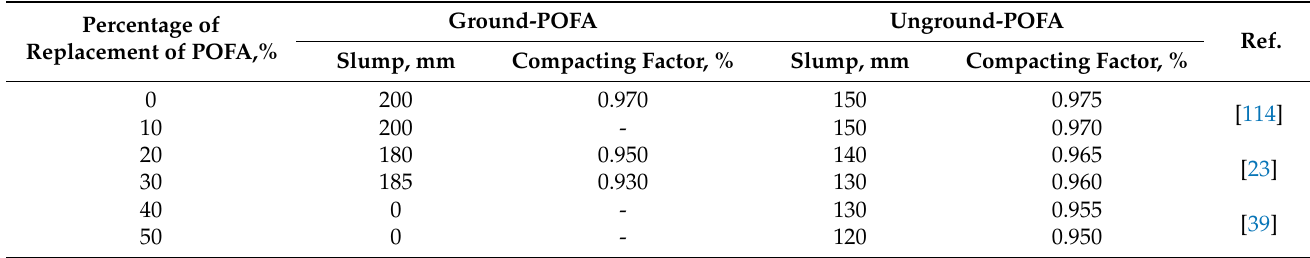
Table 5. Influence of POFA on the concrete workability.